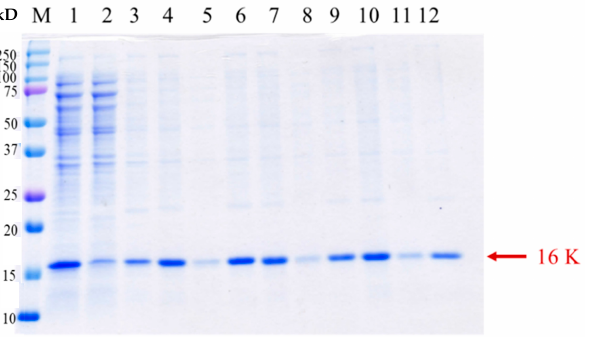
Figure 3. Dissolving 8 α -MSH inclusion body using urea solution (2–6 M). Lane M—marker (kDa);